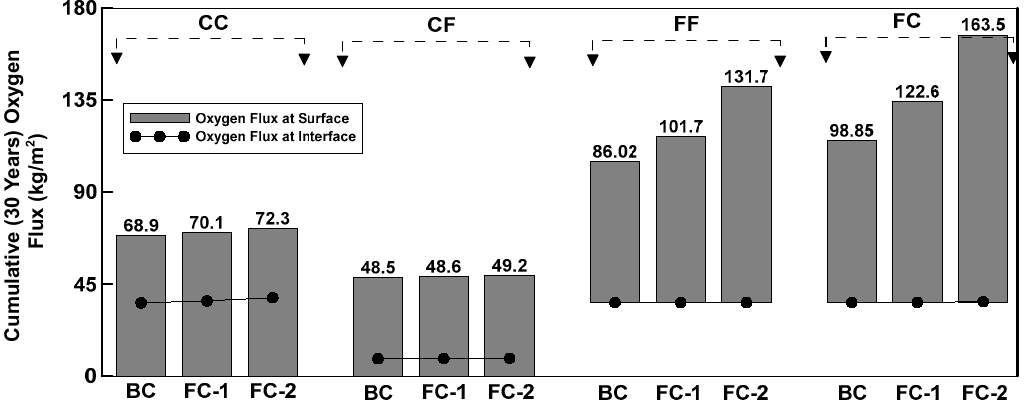
Figure 11. Cumulative (30 years) oxygen flux at the coarse and fine tailings covers for the base and the future climates.